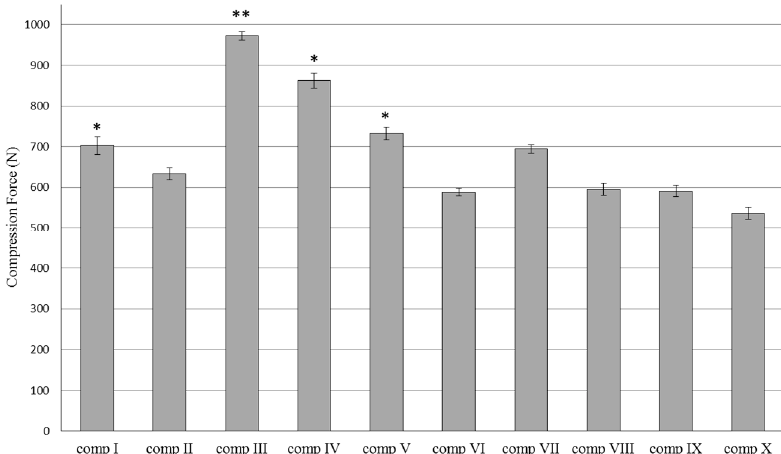
Figure 1. Resistance of silymarin cream formulations I–X, determined as compression force (N). Each data point represents the mean ± S.D., n = 5. Repeated-Measures ANOVA and for quantifying associations between the groups, Pearson correlation had been performed. Significant differences were marked in the figure with * ( p < 0.01), and ** (p < 0.1), which show the significance levels in the case of compositions containing SM in suspended or dissolved forms.